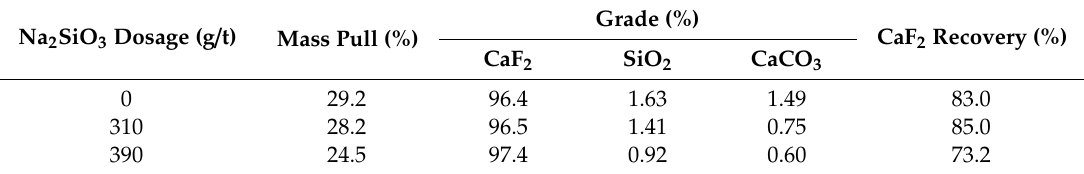
Table 7. E ff ect of sodium silicate on CaF 2 grade and recovery.